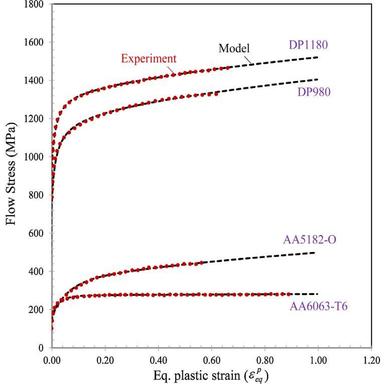
10. Comparisons of the calibrated MHS hardening model with the experimental stress response obtained using tensile and shear tests in the rolling or extrusion direction.